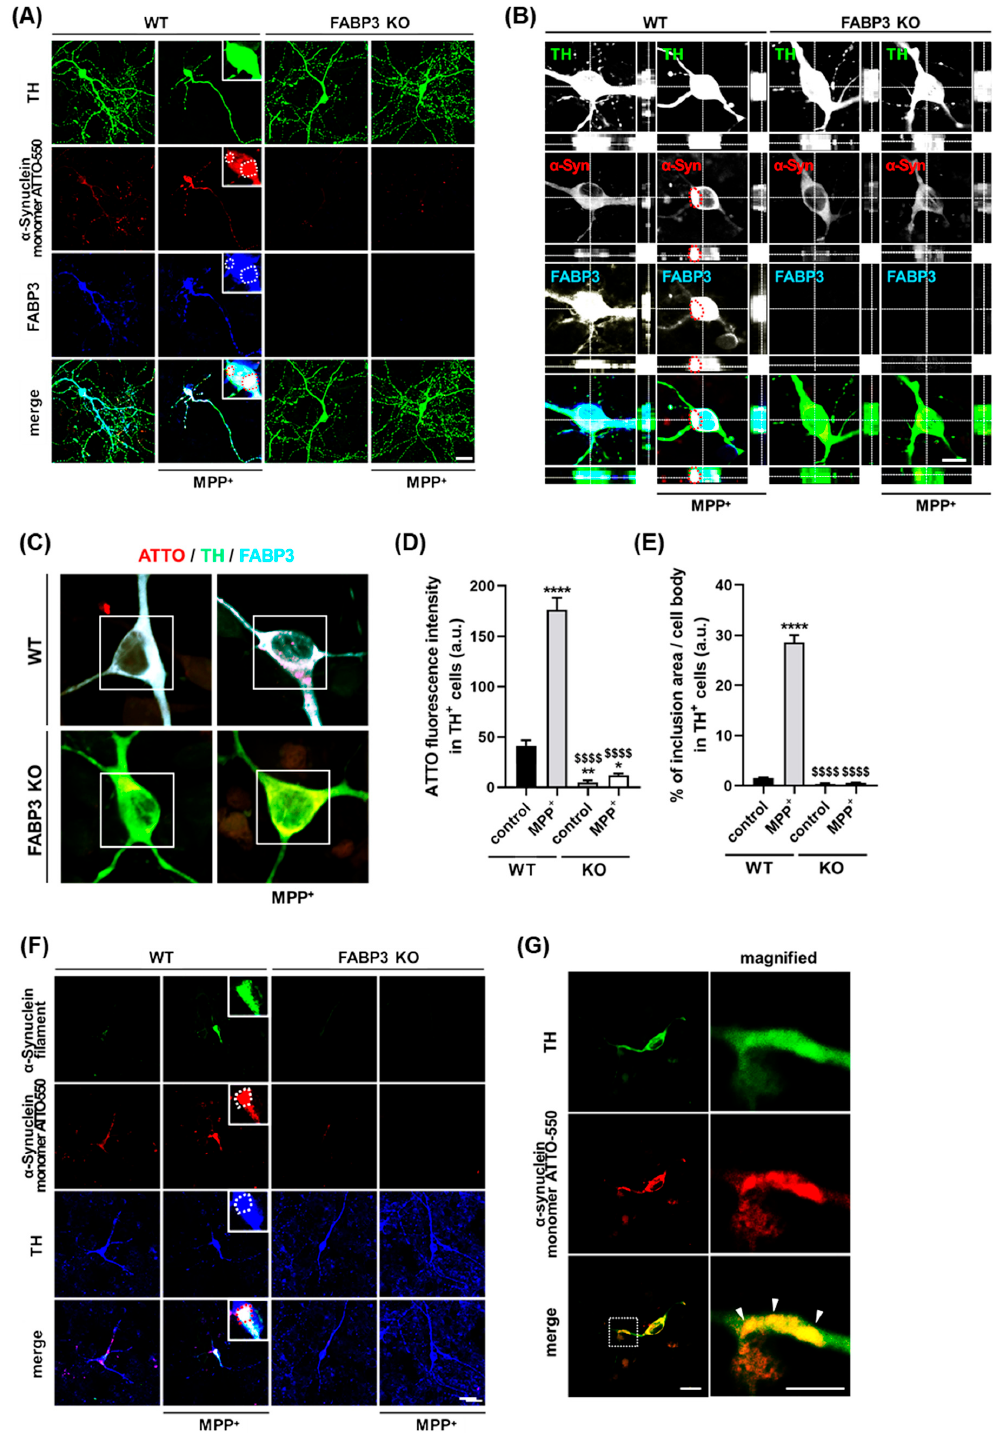
Figure 2. FABP3 is required for the formation of α -Synuclein inclusions in 1-methyl-4-phenylpyridinium (MPP + )-treated dopaminergic neurons. ( A ) Representative images of TH + mesencephalic neurons at DIV 12 derived from wild type (WT) and FABP3 − / − C57BL6 mice. Neurons were exposed to 1 μ M ATTO-550-labeled α -Synuclein monomer with or without 10 μ M MPP + for 48